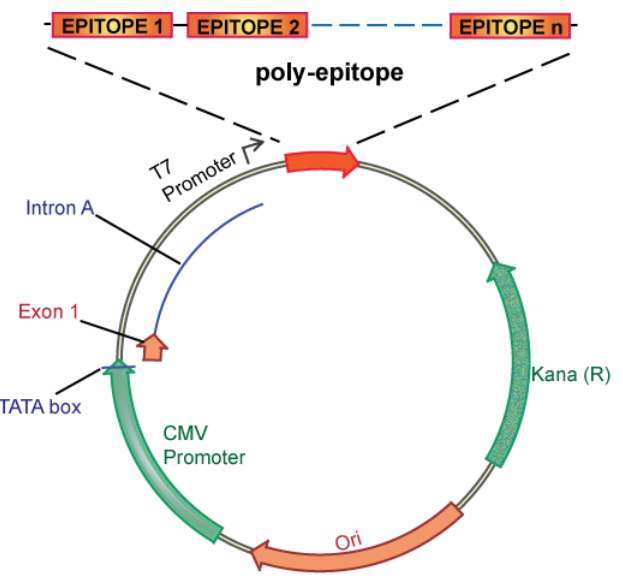
Figure 3. Template of a polyepitope DNA